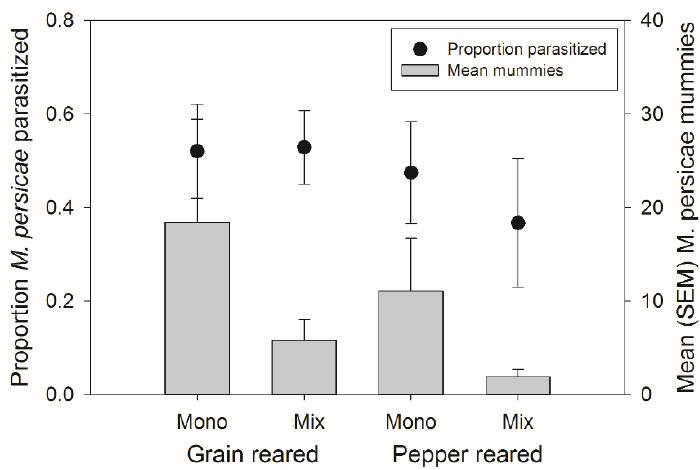
Figure 6. Mean (±SEM) percent of parasitism occurring on the crop (left axis, circles) and mean (±SEM) number of mummies on the crop (right axis, bars) from both natal habitats (Grain or Pepper reared) and both treatments (Monoculture or Mixture). There were no significant differences in the number of mummies or percent of mummies occurring on the crop plant.